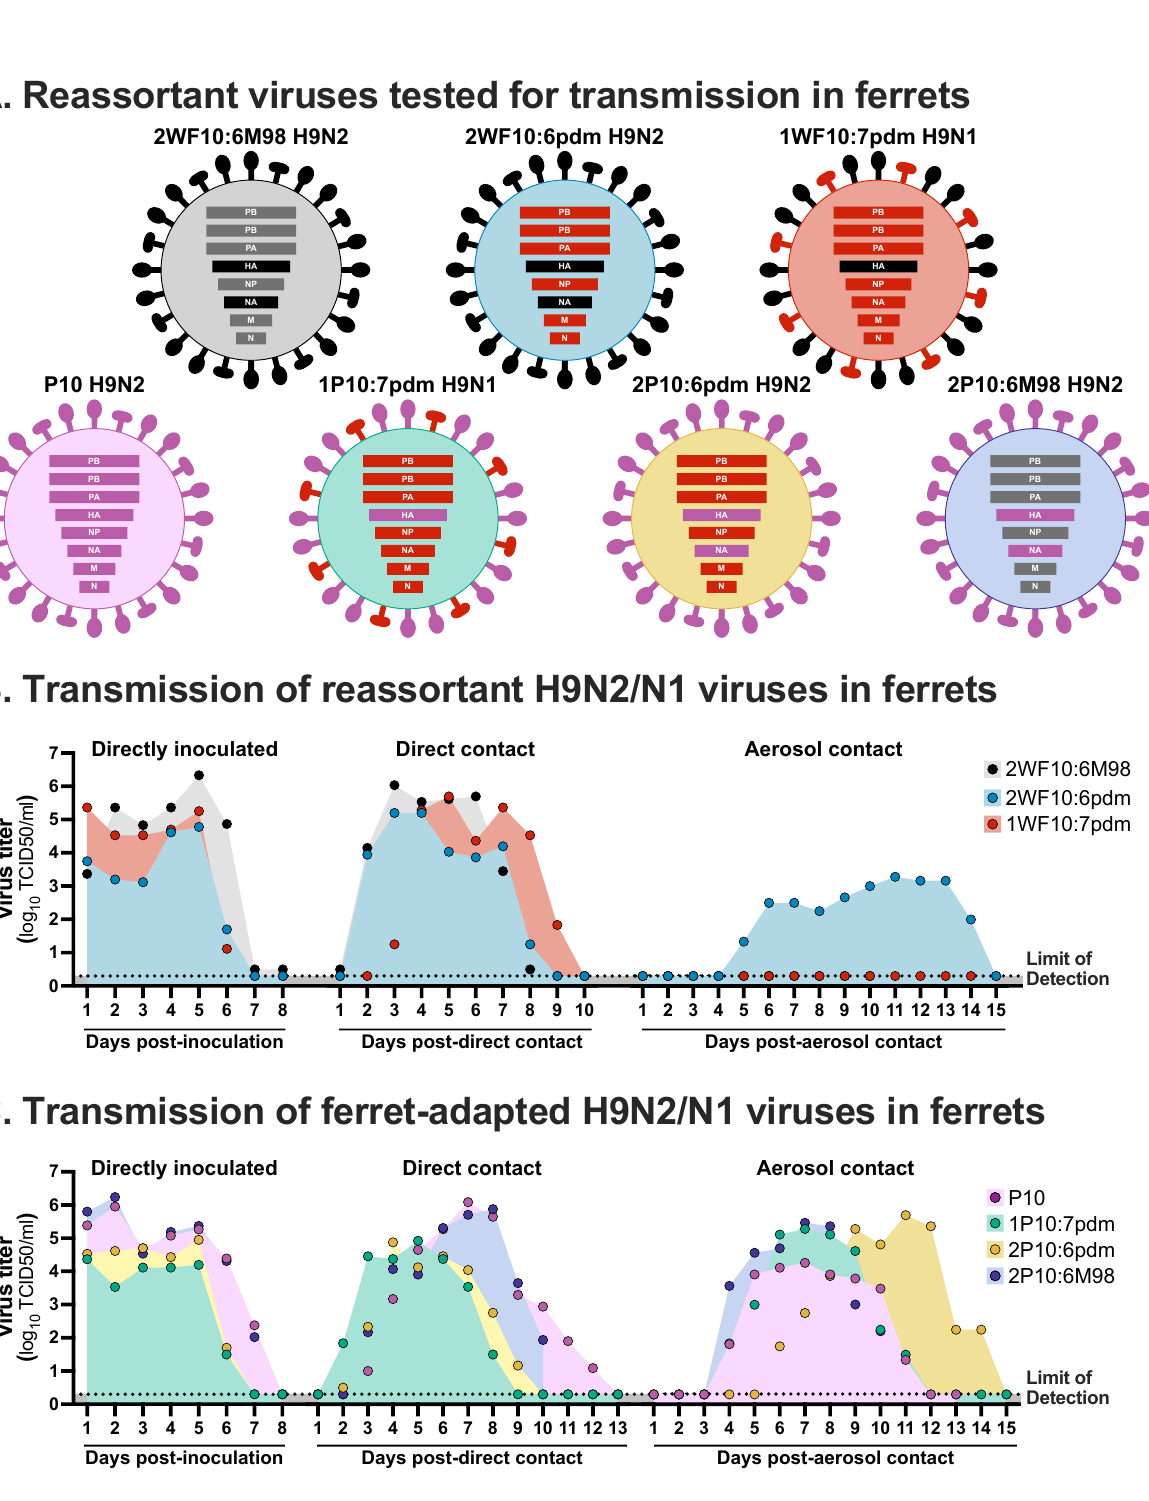
Figure 2. Transmission of reassortant and adapted H9 viruses in ferrets. ( A ) Schematic representation of the different reassortant viruses evaluated in ferrets. ( B ) Replication and transmission by direct contact or airborne in ferrets of viruses carrying the H9N2 subtype with internal genes of a seasonal H3N2 virus (2WF10:M98 H9N2) or pandemic H1N1 virus (2WF10:6pdm H9N2 or 1WF10:7pdm H9N1). ( C ) Replication and transmission by direct contact or airborne in ferrets of a virus carrying the H9N2 subtype with internal genes of a seasonal H3N2 virus adapted by serial passages in ferrets (P10). Viruses containing the HA (1P10:7pdm) or the HA/NA (2P10:6pdm) of the P10 virus and internal genes of a pandemic H1N1 virus, or HA/NA of the P10 virus and internal genes of a seasonal H3N2 (2P10:6M98) were also evaluated. Results compiled from